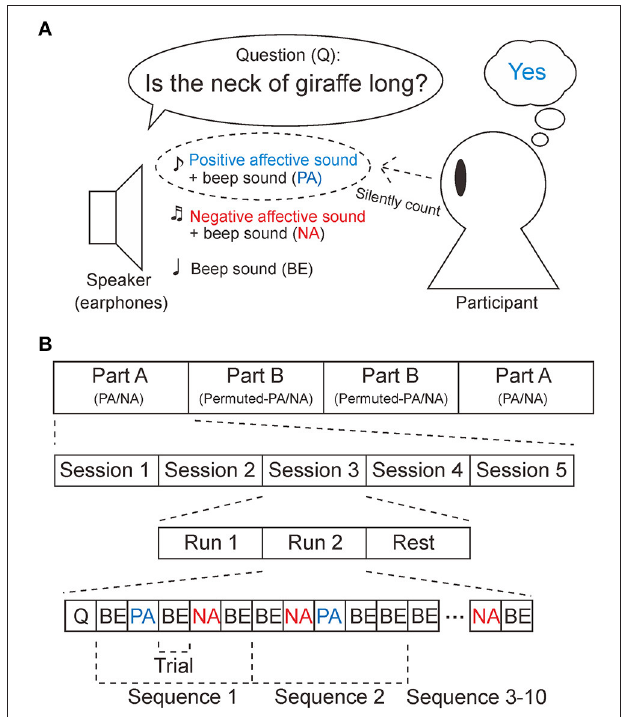
FIGURE 1 | Task and experimental design. (A) Participants were asked to perform the oddball task in response to the sounds played through the earphones. First, a question to be answered “yes” or “no” was provided. If the answer was “yes,” the participants counted the positive affective sounds (PA). If the answer was “no,” the participants counted the negative affective sounds (NA). Note that the PA stimuli and NA stimuli were mixed with a 1,000Hz sinusoidal waveform (beep sound). In the control experiment, PA and NA were replaced by permuted-PA and permuted-NA, respectively. (B) This experiment consisted of four parts (part A 2, part B 2), five sessions, and two runs. × × Part B was designed as a control experiment. In part A, PA, NA, and beep sounds (BE) were provided, while permuted-PA, permuted-NA, and B were provided in part B. Participants were asked to rest between sessions, At the beginning of a run, a yes/no question (Q) was provided. EEG measurements were taken during the tasks for PA, NA, permuted-PA, and